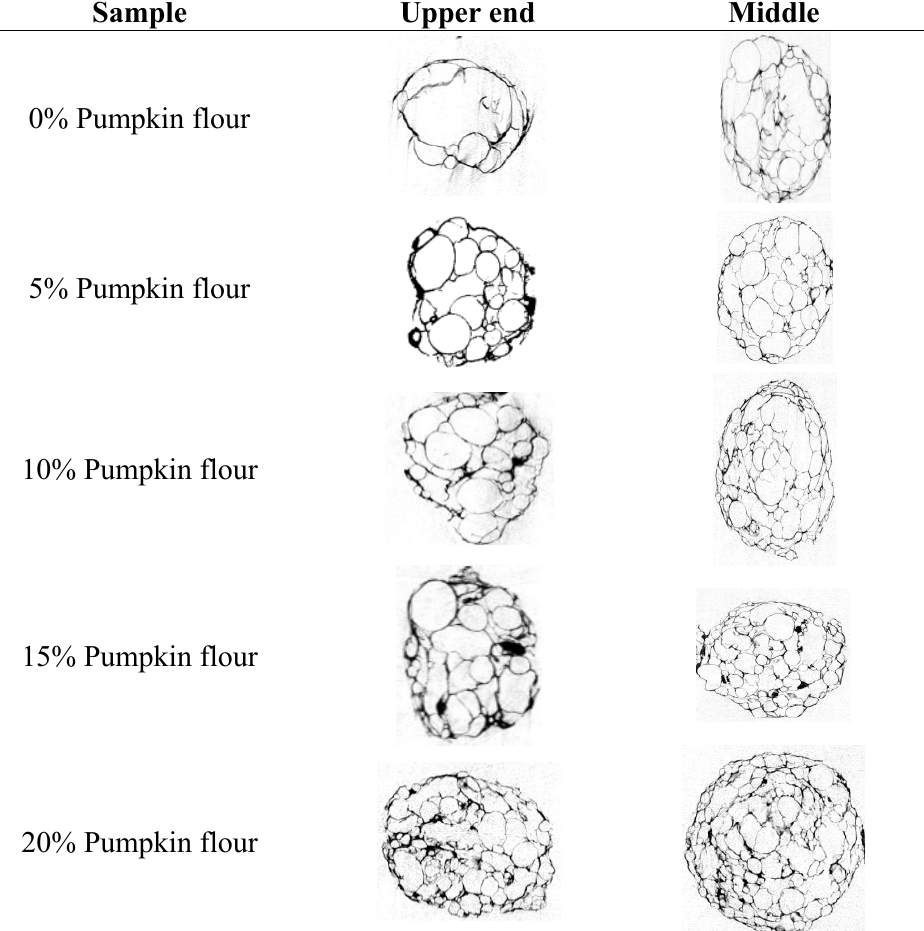
Table 2. X-ray tomography cross sectional of 2-D image (radial): changes of bubble size through out the extruded sample at screw speed 250 rpm (scale